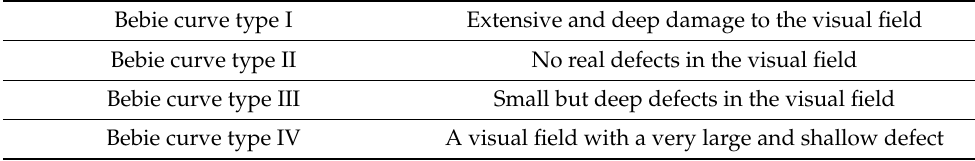
Table 1. Classification of the centralized defect of a VF test result (Bebie curve). Bebie curve type I Extensive and deep damage to the visual field Bebie curve type II No real defects in the visual field Bebie curve type III Small but deep defects in the visual field Bebie curve type IV A visual field with a very large and shallow